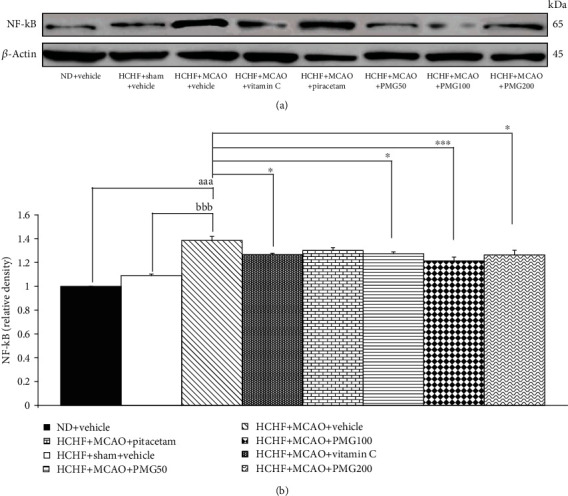
Effect of various doses of PMG on the expression of NF-κB in the cerebral cortex was detected by Western blotting. (a) Representative western blot showing the levels of NF-κB. (b) Relative density of NF-κB. Data are presented as mean ± SEM (n = 6/group). aaap values < 0.001; compared between naïve control rats which received normal diet and vehicle, and metabolic syndrome+MCAO rats which received HCHF, MCAO, and vehicle, bbbp values < 0.001; compared between sham rats which received HCHF, sham operation, and vehicle, and metabolic syndrome+MCAO rats which received HCHF, MCAO, and vehicle and ∗, ∗∗∗p values < 0.05 and 0.001, respectively; compared to metabolic syndrome+MCAO rats which received HCHF, MCAO, and vehicle. ND: normal diet; HCHF: high-carbohydrate high-fat diet; MCAO: middle cerebral artery occlusion; vitamin C: the vitamin C at a dose of 250 mg.kg−1 BW; piracetam: the piracetam at a dose of 250 mg.kg−1 BW; PMG 50, PMG 100, and PMG 200: the phytosome containing the combined extract of mulberry fruit and ginger at doses of 50, 100, and 200 mg.kg−1 BW, respectively.